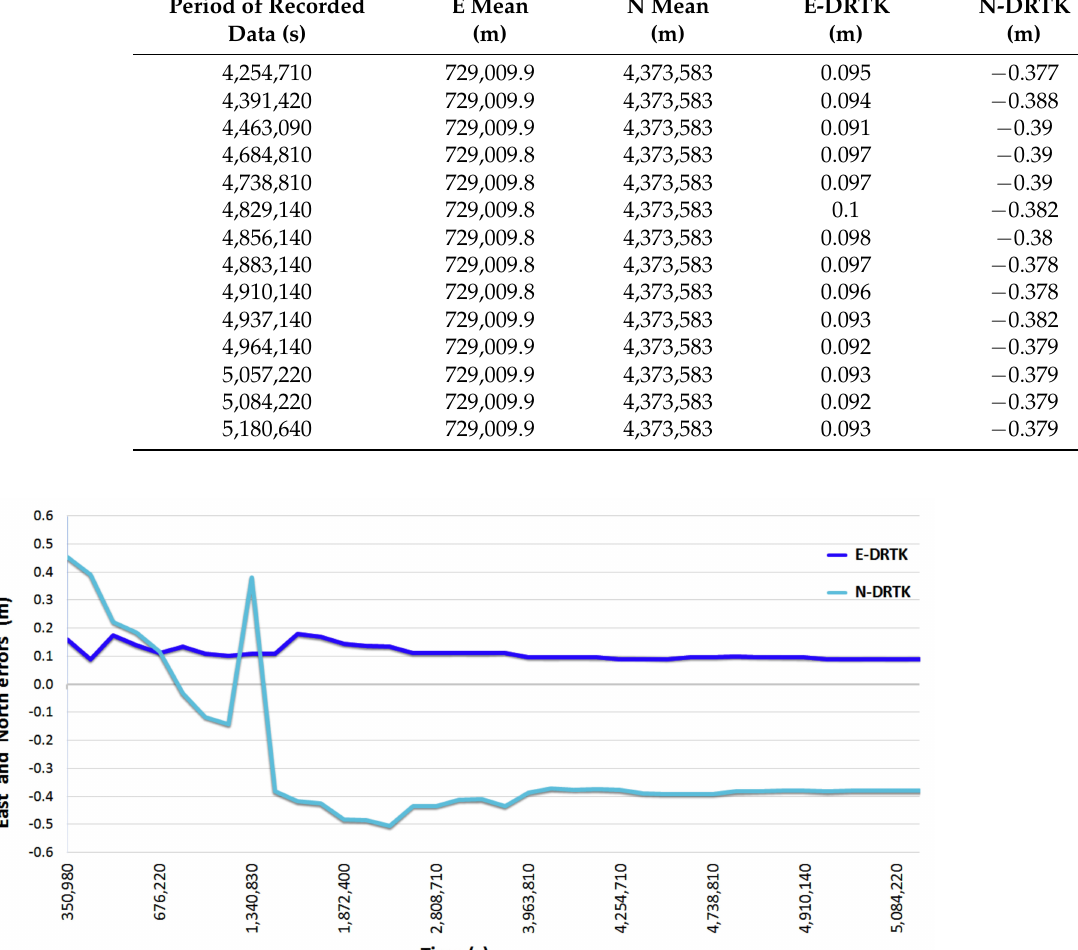
Figure A1. The relationship between the time and the East and North errors of Garmin Etrex 30 device. East and North errors are the differences between the control point and coordinate means. Table A2. Trimble Geo XT device period of recorded data, and coordinate means for E and